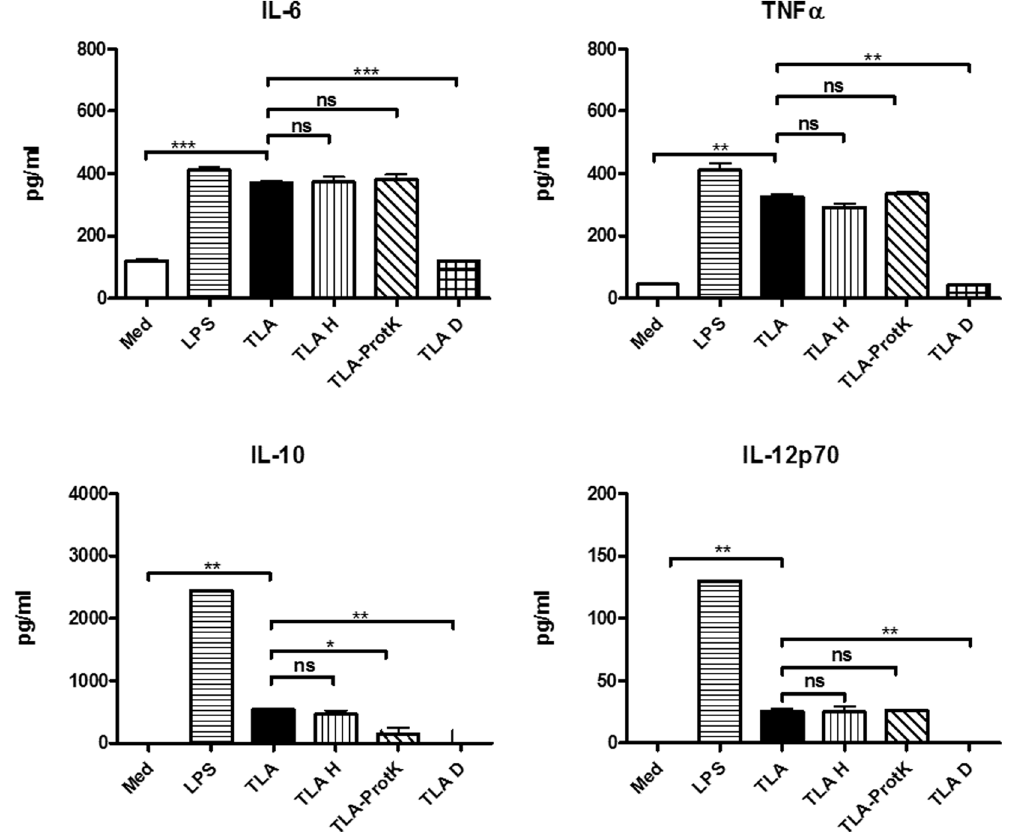
Figure 7. In vitro stimulation of bone marrow-derived dendritic cells with heat-inactivated, proteinase K-treated and deglycosylated TLA. Bone marrow-derived dendritic cells (BMDC) were cultured with media only (Med), 5 µ g/ml TLA (TLA), heat-inactivated TLA (TLA H), TLA digested with proteinase K (TLA-ProtK), or deglycosylated TLA (TLA D), and LPS (1 µ g/ml) for 24 h. Levels of cytokines in culture supernatants were determined by ELISA. All data are representative of at least two independent experiments. Results of Student´s t test: * P < 0.05, ** P < 0.01, *** P <